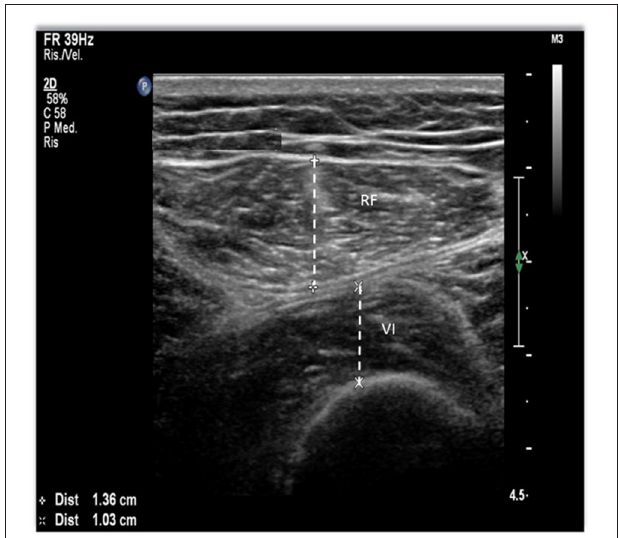
FIGURE 2 | Quadriceps muscle ultrasound (US) methodology. The points of interest correspond to the midpoint and the lower third between the anterior superior iliac spine (ASIS) and the upper pole of the patella. Using a B-mode ultrasound with a linear transducer, we obtain the image on the right. Rectus femoris (RF) and vastus intermedius (VI) thickness, a measure on the inner edge of the